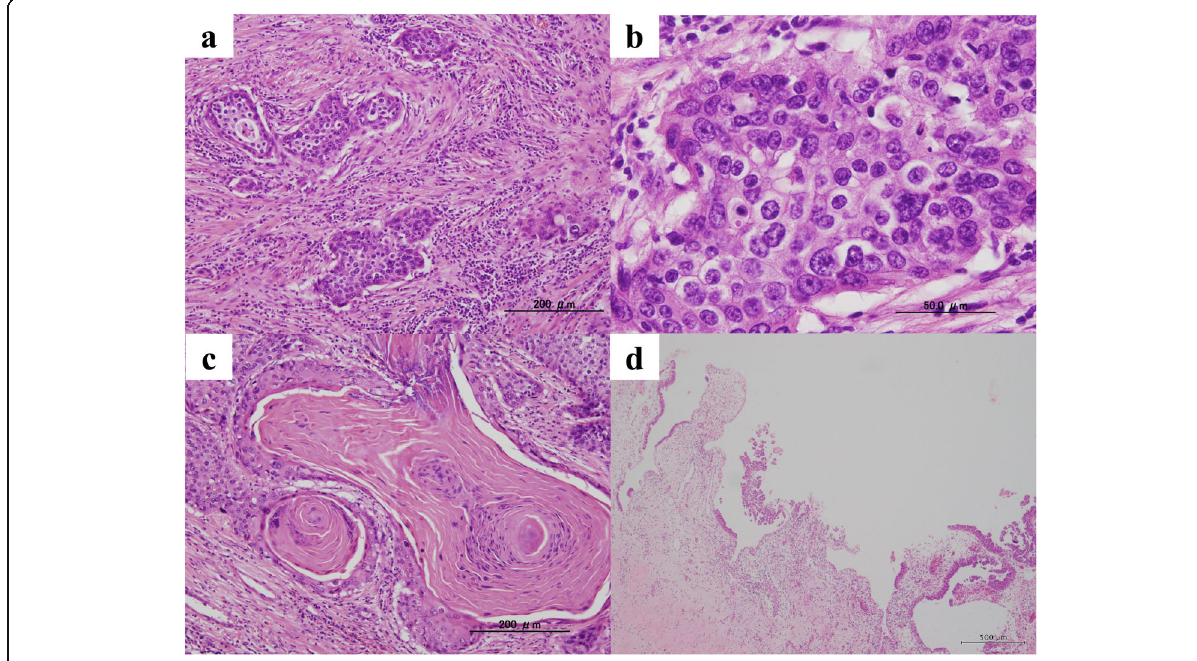
Fig. 4 Histological findings in the surgical specimen. The tumor shows an invasive growth pattern ( a ; scale bar = 200 μ m, hematoxylin and eosin [H&E] staining; × 10) and solid/diffuse proliferation of highly atypical urothelial-like cells with large, irregular, and pleomorphic nuclei ( b ; scale bar = 50 μ m, H&E staining, × 40). Apparent keratinization was only partly observed. c ; scale bar = 200 μ m, H&E staining, × 10). Non-neoplastic uroepithelium (left) and adjacent focus of urothelial carcinoma in situ (right) are present in the renal pelvis. d ; scale bar = 500 μ m, H&E staining, ×